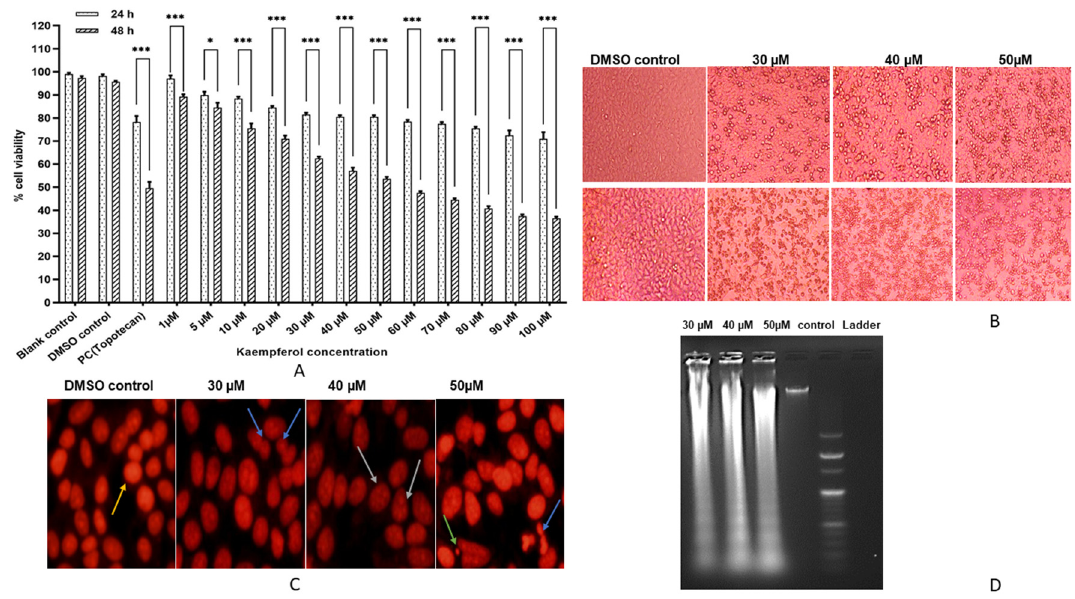
Figure 1. Kaempferol exhibits cytotoxic effect on HeLa cells ( A ) Graph presenting concentration and time dependent reduction in cell viability of HeLa cells after treatment with kaempferol (1–100 µM) for 24 h and 48 h, respectively, In all the assays, the effect of drug on treated cells was compared with DMSO controls. The half inhibitory concentration (IC50) of kaempferol was found to be 50 µM at 48 h. The data are expressed as the mean ± standard deviation of three independent experiments. Statistically significant differences are marked by asterisks: Two way-ANOVA * rep- resents p < 0.05. *** p < 0.001. ( B ) Microscopic analysis of treated cells: Kaempferol treated HeLa cells at various concentrations (30, 40 and 50 µM) at 24 h and 48 h illustrated characteristic round- ing off of the dead cells, signifying apoptosis at 10 × Magnification. ( C ) Nuclear morphology after PI staining of kaempferol-treated HeLa cells (30, 40 and 50 µM) shows a concentration-dependent increase in apoptotic index. Orange = prominent intact nuclei, Blue = membrane blebbing, Gray = nuclear fragmentation, green = Apoptotic bodies. ( D ) Kaempferol treated HeLa cells with 30, 40, 50 µM for 48 h produced a DNA laddering pattern on agarose gel in concordance with nuclear fragmentation, a characteristic feature of apoptosis. 3.2. Kaempferol Mediates Nuclear Aberrations and DNA Fragmentation Treated HeLa cells with kaempferol 30, 40, and 50 µM demonstrated fragmentation, nuclear blebbing, and apoptotic body formation, and the effect was found to be more pro- nounced with increasing concentration. In contrast, the control cell’s nucleus was intact and conspicuous. Moreover, DNA analysis of the kaempferol-treated cells (30, 40 and 50 µM) for 48 h demonstrated that kaempferol efficiently reduces the DNA integrity and consequently induced DNA ladder formation in treated cells in a dose-dependent man- ner, as evident via agarose gel electrophoresis, whereas the DNA of the control cells re- mained intact (Figure 1C,D). 3.3. Kaempferol Induces G2/M Arrest in HeLa Cells To determine whether Kaempferol affects HeLa cells’ proliferation by arresting the cell cycle, DNA content of different phases of the cell cycle was evaluated and compared with the untreated control. Kaempferol treatment halts the cell cycle at the G2/M phase; the cells’ population was raised in a dose-dependent manner from 19.4%, 32.8% to 46.7% at 30, 40 and 50 µM, respectively at 48 h, compared to 10.7% in the DMSO control. How- ever, at 50 µM there was a concomitant increase in Sub-G1 population from 1.23% to 7.05% (Figure 2A,B).